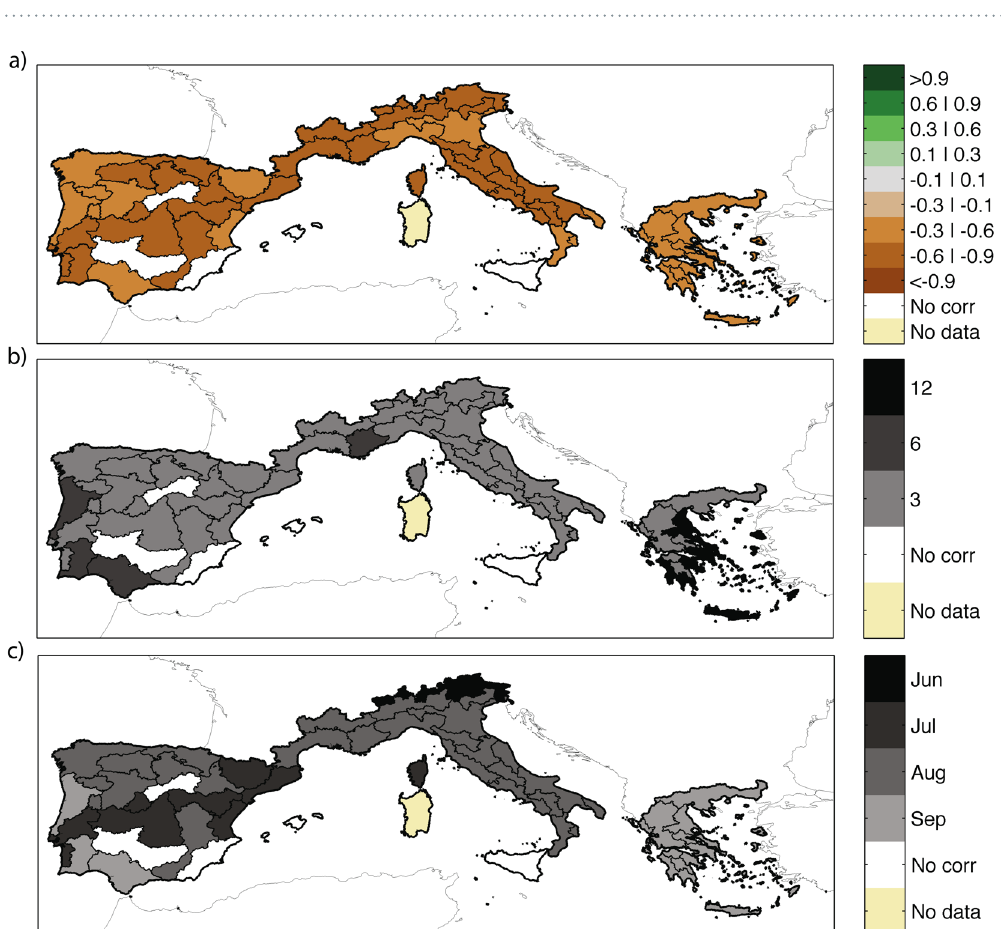
Figure 2. ( a ) Maximum significant correlation (in absolute value) between detrended log( BA ) and SPEI; ( b ) length of the period (3, 6 and 12 months) and ( c ) final month of accumulation of the SPEI for which the absolute value of the correlation is maximum. Only correlations that are collectively significant from an FDR test 45 are shown. This figure is created with Matlab version R2012a